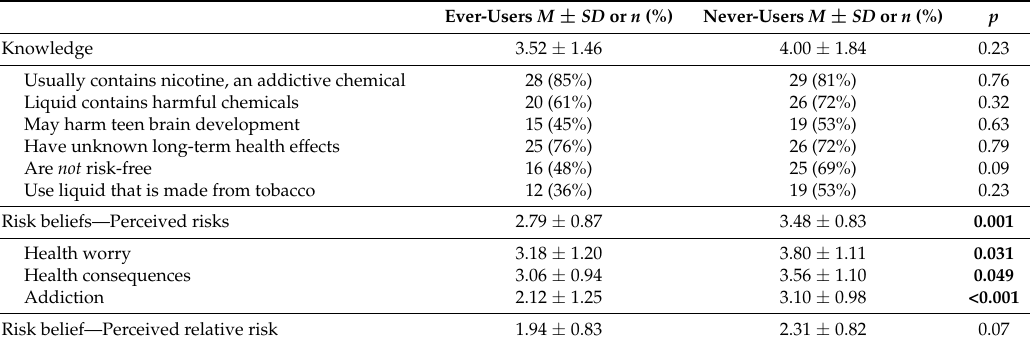
Table 2. Knowledge and beliefs about e-cigarettes, N = 69